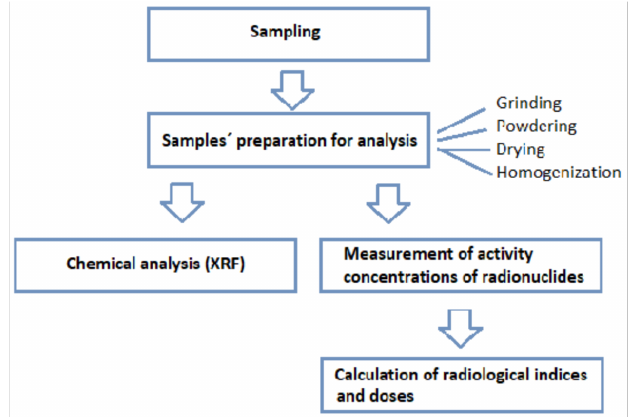
Figure 1. Schema of the steps and tools in the